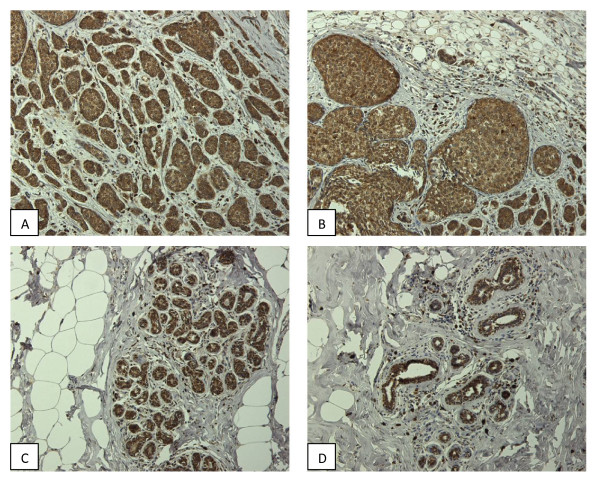
Breast cancer (A,B) and normal breast tissue (C,D) staining of FTO. As shown here there is strong cytoplasmic staining for FTO in the breast tissue whereas the surrounding adipose tissue and stroma don't show any staining for FTO.